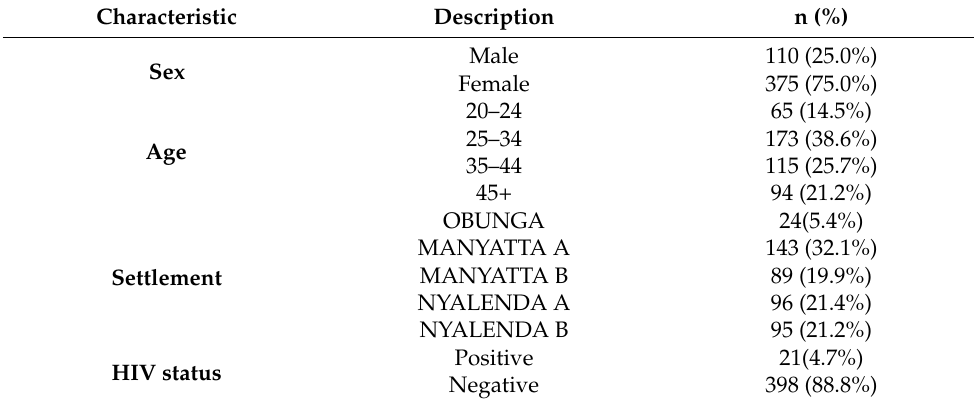
Table 1. Sociodemographic and clinical characteristics of the study